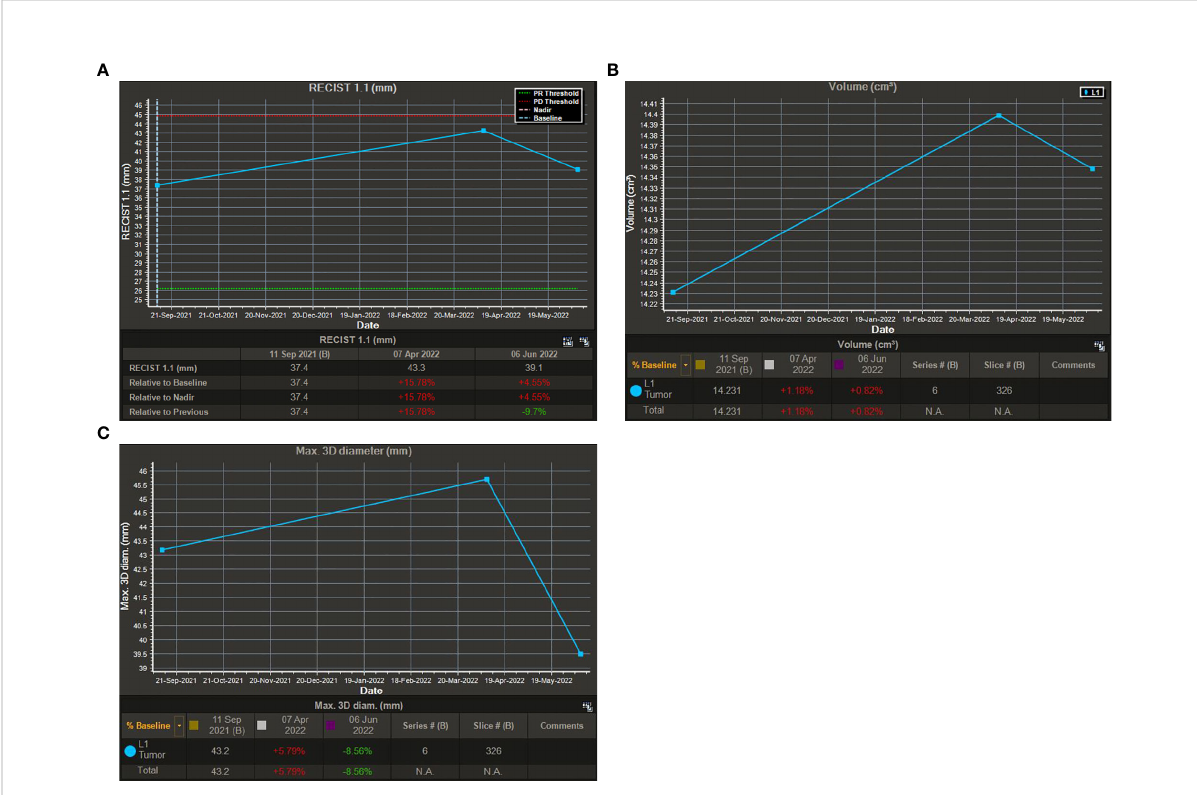
FIGURE 5 Visual charts of the semi-automatic segmentation technique. (A) : Visual chart of RECIST 1.1. (B) : Visual chart of total volume. (C) : Visual chart of max. 3D